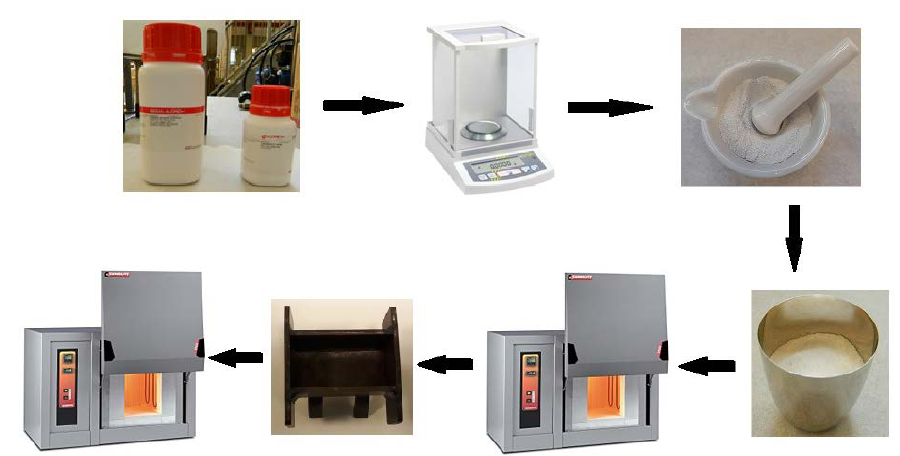
Fig. 1 Scheme of the glass samples production.